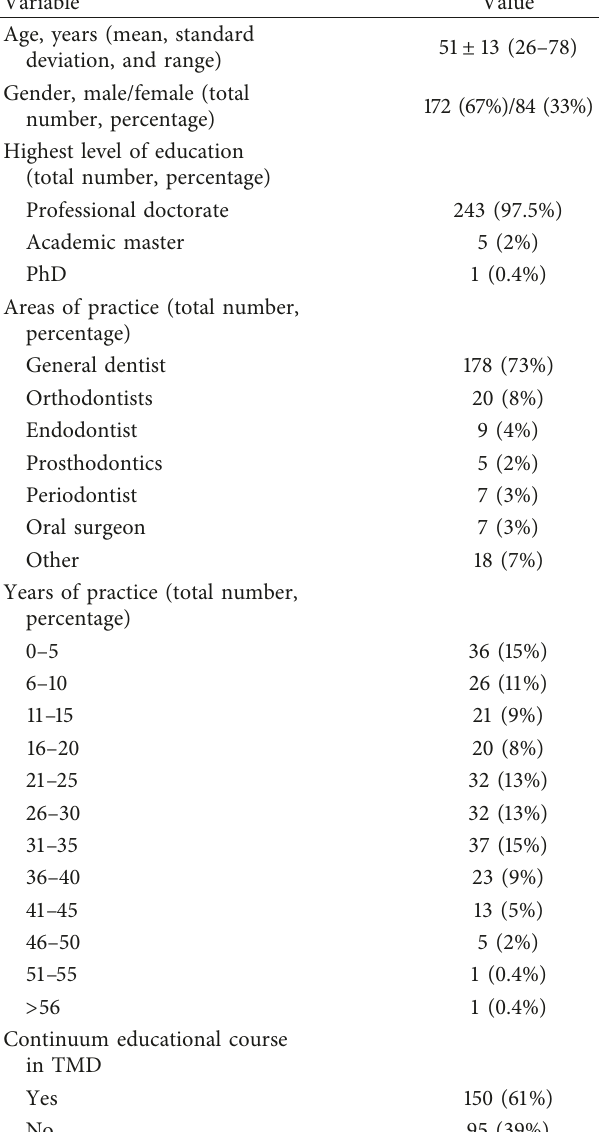
Table 1: Participants’ demographics and characteristics.